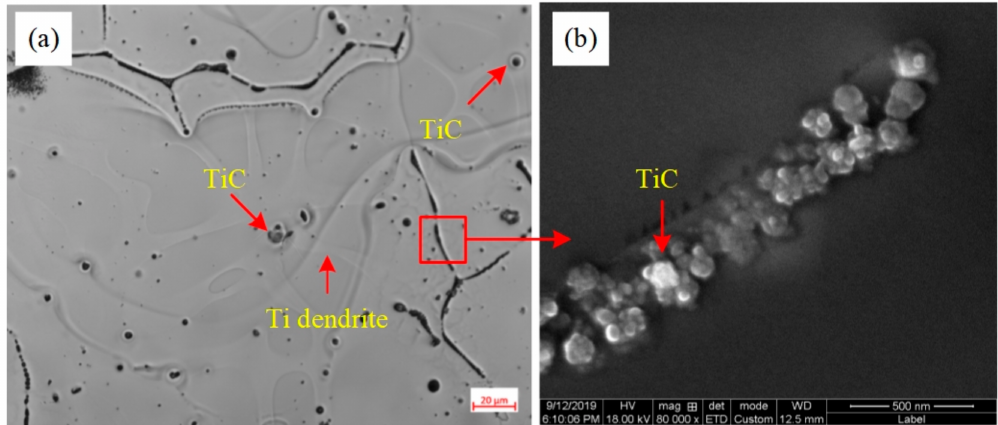
Figure 5. The grain morphologies of the distribution of TiC in A99.7 after refining: ( a ) OM image of A99.7; ( b ) SEM image on the grain boundary.